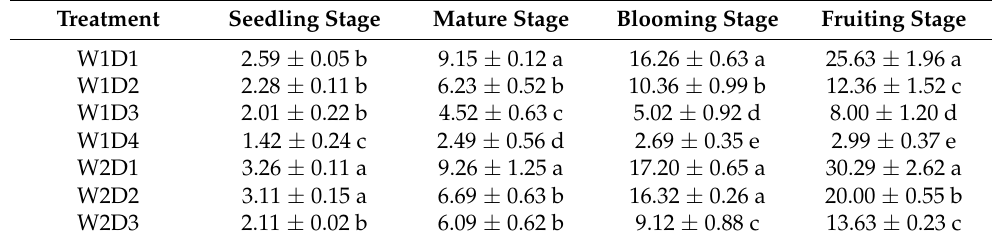
Table 2. Effect of different planting densities and irrigation volumes on the stem diameter of Suaeda salsa under drip irrigation.